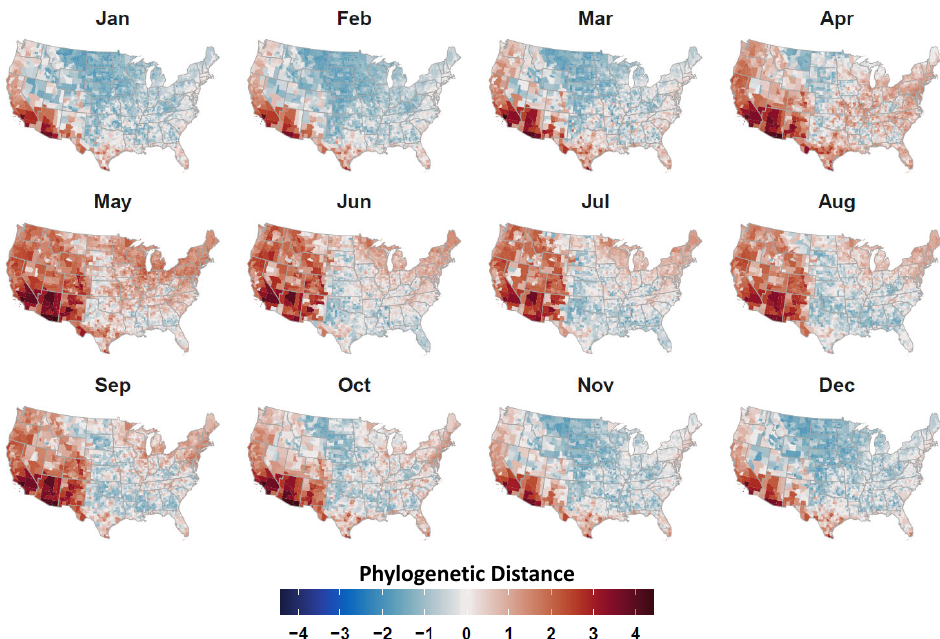
Figure A6. Dynamic avian phylogenetic distance. Phylogenetic distance covariate (sum of branch lengths) under assumption of a dynamic species pool (monthly varying). Mapped values have been centered to highlight locations subject to relative phylogenetic clustering (higher than expected relatedness, blue colors) and dispersion (lower than expected relatedness, red colors).